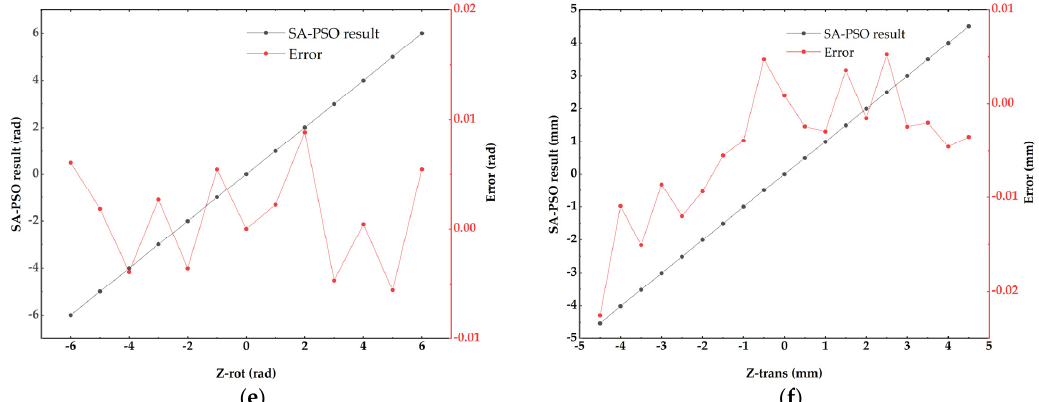
Figure 11. the SA–PSO results and the error for the experiments. ( a ) X rotation results and errors. ( b ) X translation results and errors. ( c ) Y rotation results and errors. ( d ) Y translation results and errors. ( e ) Z rotation results and errors. ( f ) Z translation results and errors.